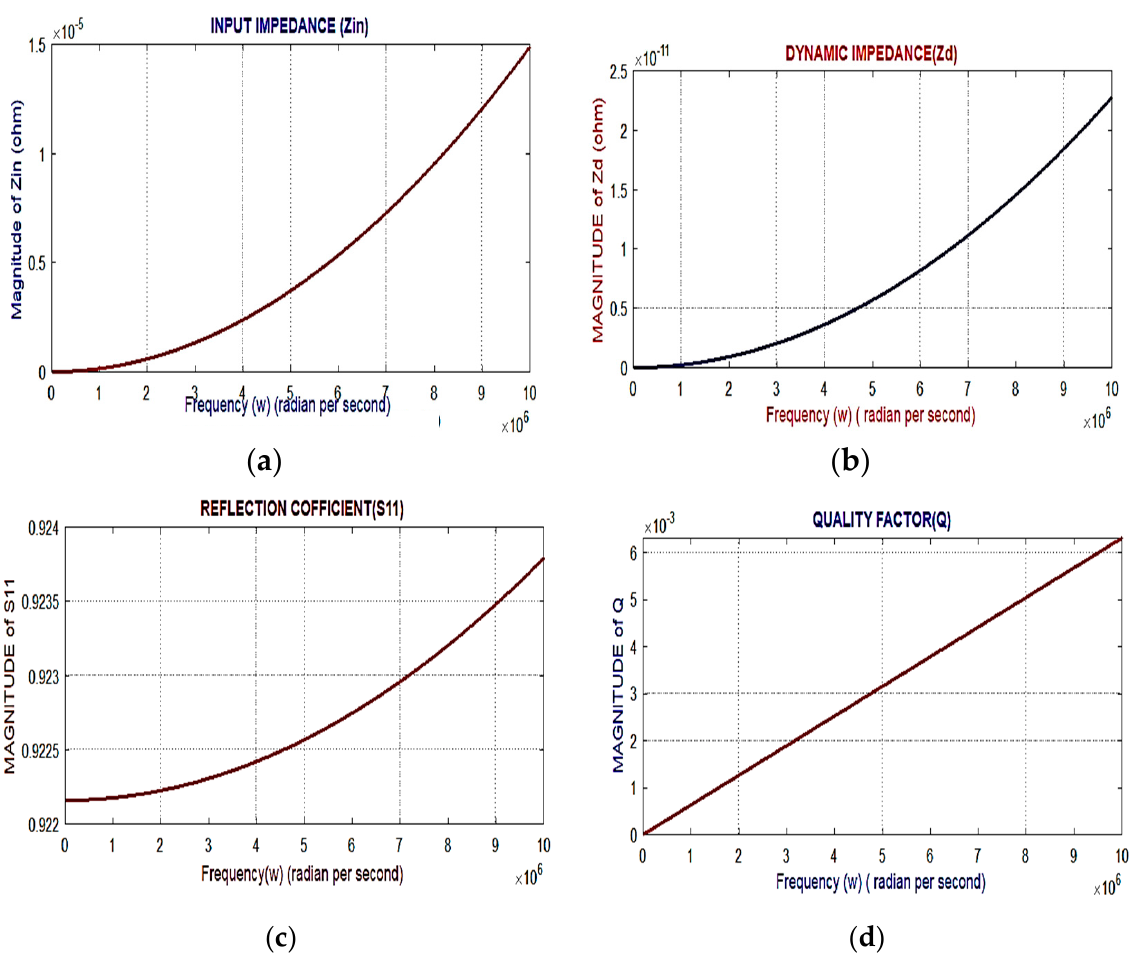
Figure 4. ( a ) Input impedance, ( b ) dynamic impedance, ( c ) reflection coefficient, and ( d ) quality factor of multi-stacked DRA.